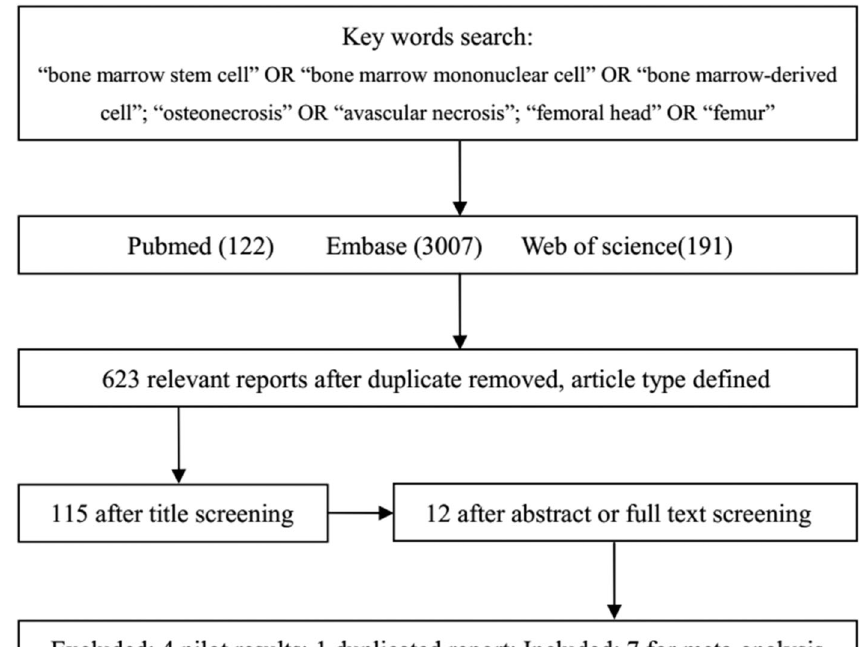
Figure 1 - Flowchart of the selection process for the